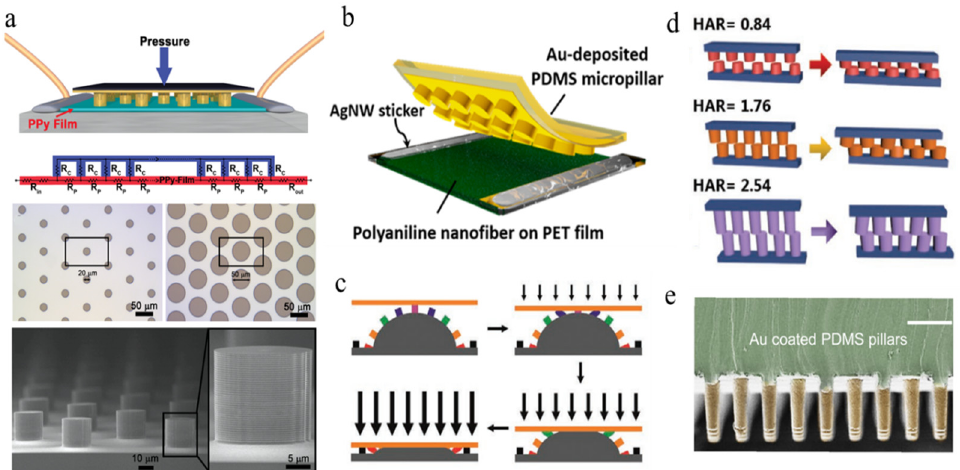
Figure 2. Schematic of micropillar array-based pressure sensor. ( a ) Detailed structure of pressure sensor based on micropillar array includes the PPy/PDMS substrate, a gold-covered micropillar array, and the optical images of photolithographically fabricated patterns [6]. ( b ) Primary design of the pressure sensor composed of PDMS micropillars and polyaniline nanofiber film [105]. ( c ) Schematic of in situ structural variation of hybrid structure under increased pressure load [106]. ( d ) Comparison of pillar-based pressure sensor with different ratio of height to diameter under pressure [107]. ( e ) SEM image of Au-coated PDMS micropillars. Scale bar: 50 μ m [108].